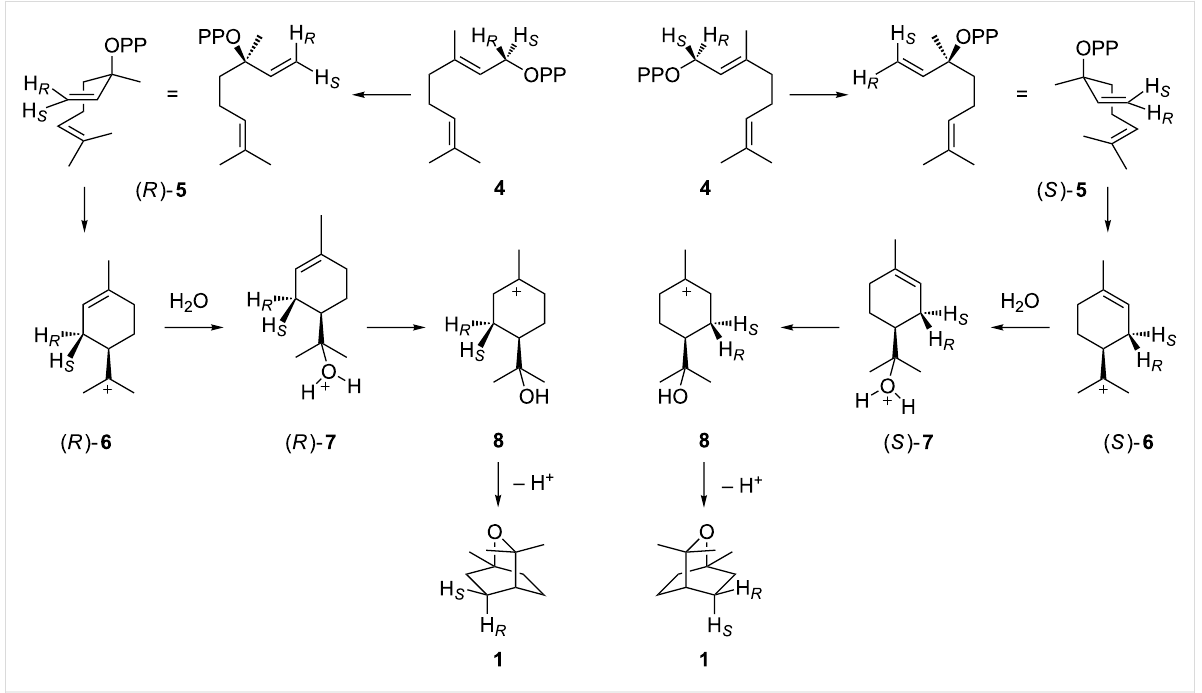
Scheme 1: Cyclisation of GPP to 1 via the ( R )-terpinyl cation (( R )- 6 , left) or the ( S )-terpinyl cation (( S )- 6 , right).